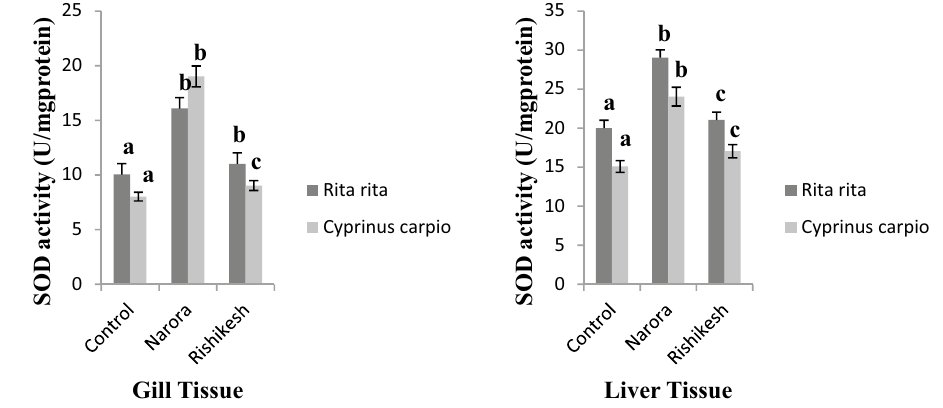
Figure 4. SOD activity in gill and liver tissues of Rita rita and Cyprinus carpio from Narora and Rishikesh. The values are expressed as mean ± SE (n = 10). Values are expressed as U/mg of protein. The significance levels observed is P ≤ 0.05 when compared with the control group.